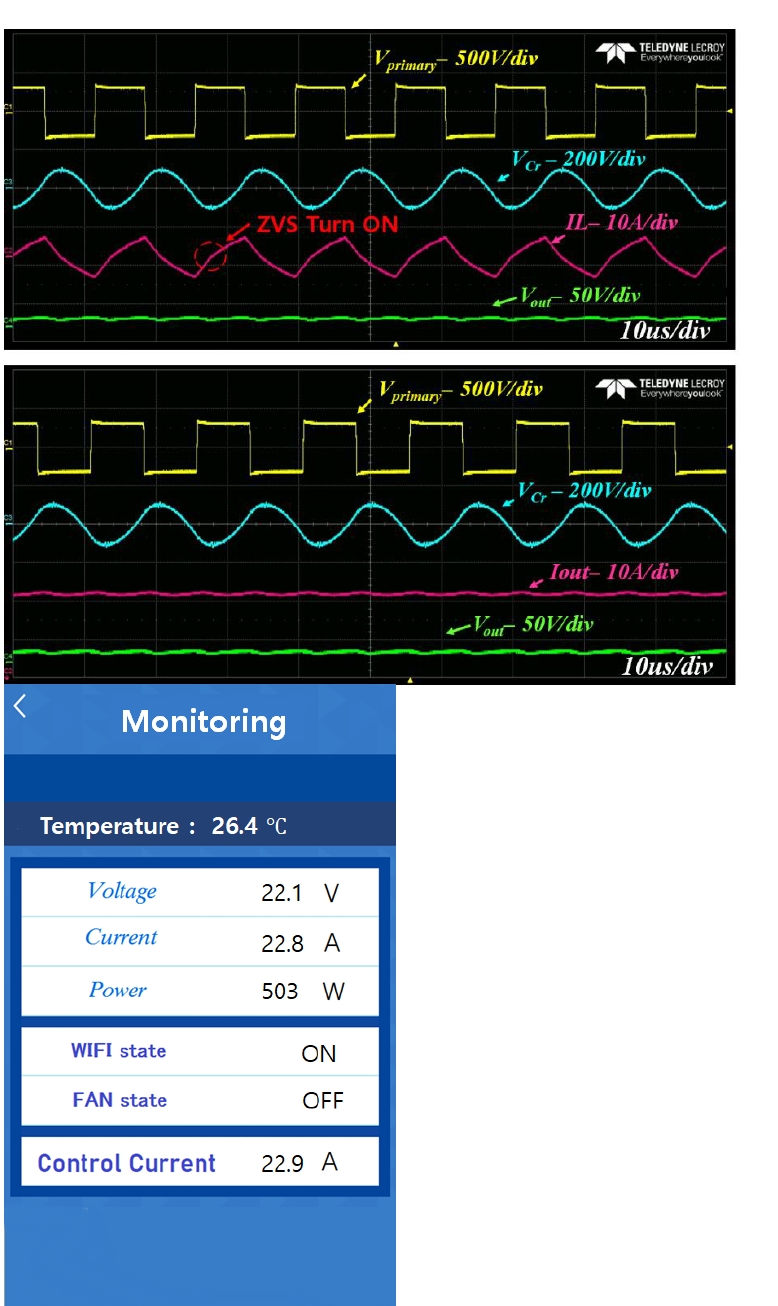
Figure 10. Charging wave form and corresponding smartphone application screen snapshots (Auto mode, Temperature = 35.3 °C.